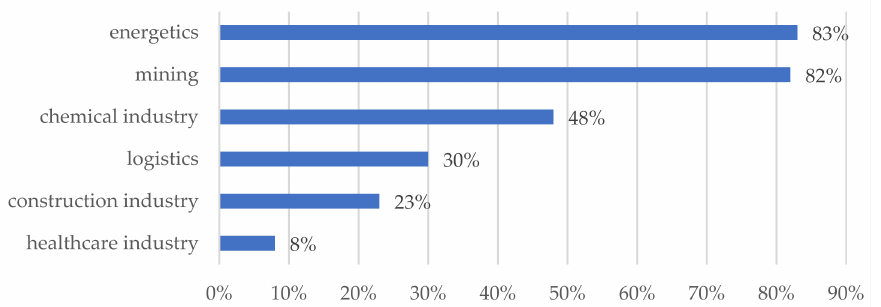
Figure 8. Statistics on responses to the question: Which sectors of the economy are most vulnerable to the impact of decarbonization